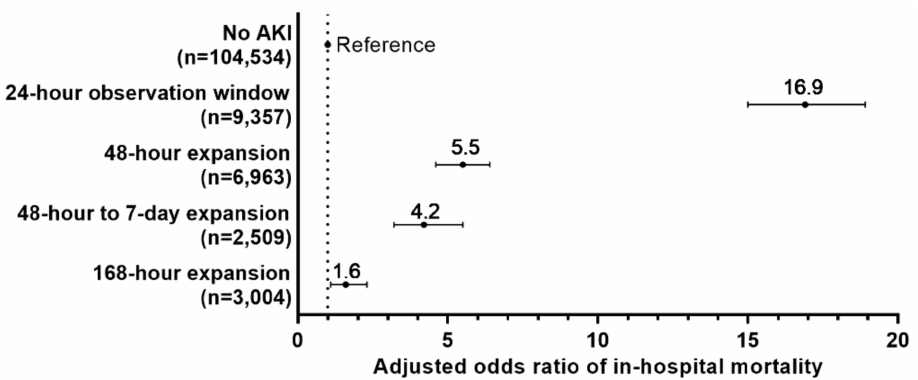
Figure 3. Increased odds of in-hospital mortality by observation window expansion ( n = 126,367). AKI, acute kidney injury; KDIGO, Kidney Disease: Improving Global Outcomes. Adjusted odds ratios (dots) and 95% confidence intervals (lines) were calculated using bootstrap sampled multi- variable logistic regression where the reference category were patients who did not develop AKI. Logistic regression was adjusted for hospital admission status (elective/unknown, urgent, and emer- gency), estimated GFR in categories of 15 mL/min/1.73 m 2 based on first hospital serum creatinine, gender, hospital type (academic medical center vs. community hospital), and baseline comorbidi- ties of diabetes, anemia, hypertension, congestive heart failure, liver disease, and peripheral and visceral atherosclerosis.